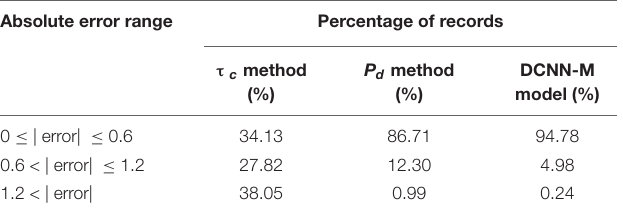
TABLE 1 | The distribution of the magnitude estimation errors for the τ c method, P d method, and DCNN-M model.